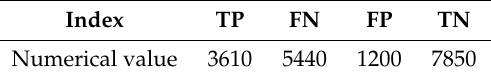
Table 26. Forecast indices value.